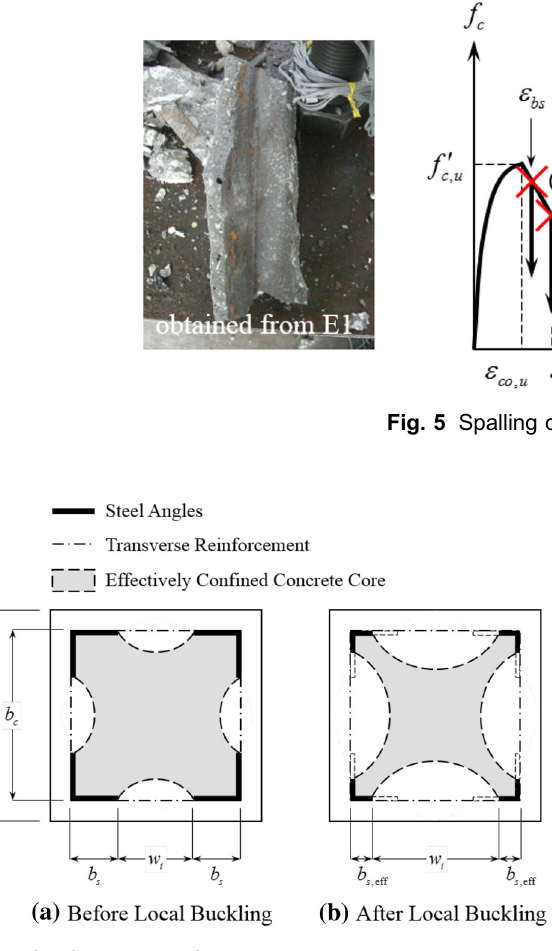
Fig. 6 Confinement of steel angles and transverse reinforcement.